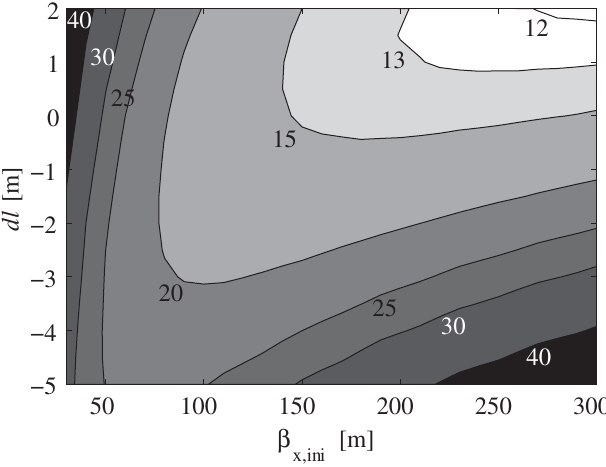
FIG. 9. Contour plot of the emittance growth in a C-chicane versus dipole shift dl and initial beta function (cid:3)